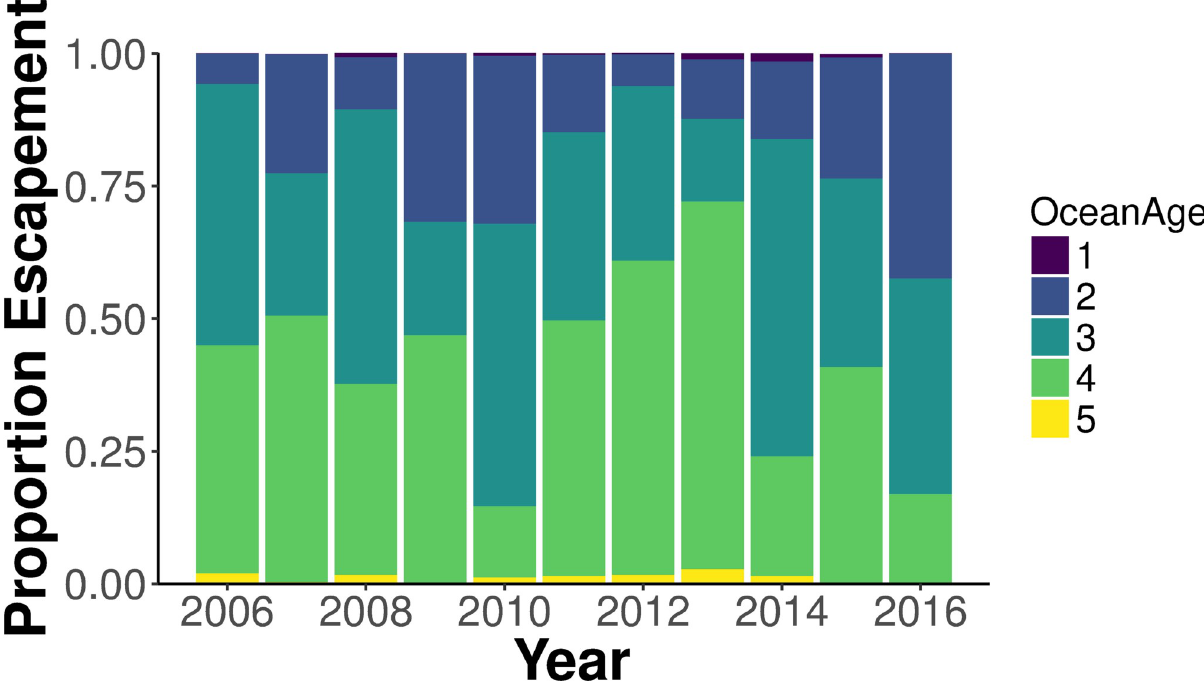
Fig 1. The age composition of Chinook salmon adult returns to the Salcha River, 2006–2016 [16–26].